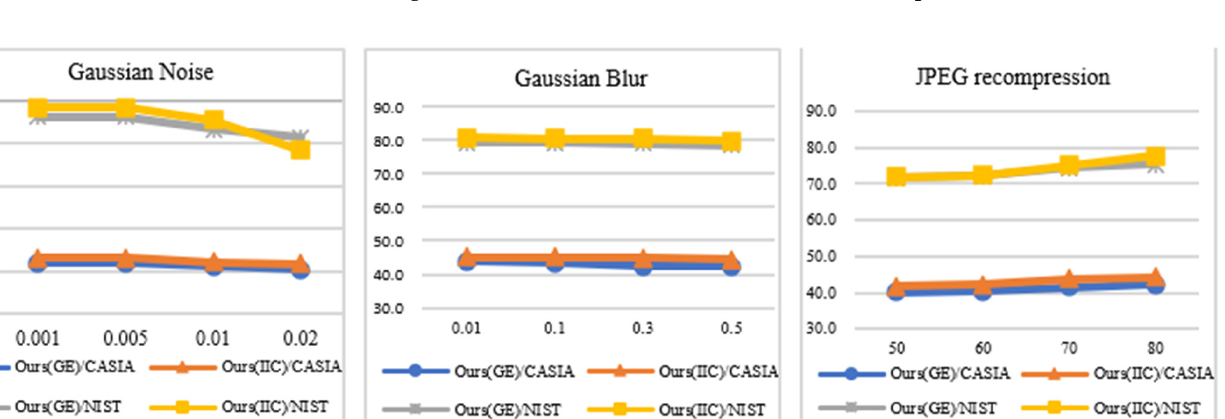
Figure 6. Exemplar visual results on NIST16 dataset. From left to right: the first two columns are tampered images and Ground-Truth, the third to fifth columns are results of the tampered images, tampered images with noise (0, 0.02), blur (3 × 3, 0.5) and JPEG (50).